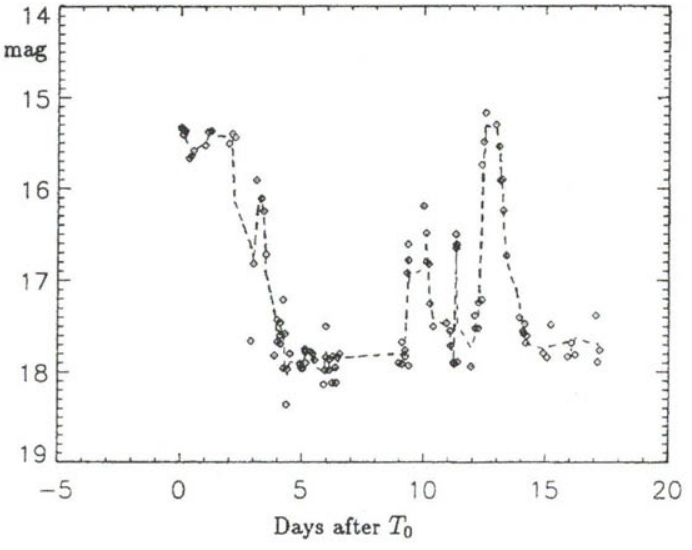
Fig. 1. The light curve for CRBoo, averaged over 3 h, during XCOV1. The magnitudes are in the WET